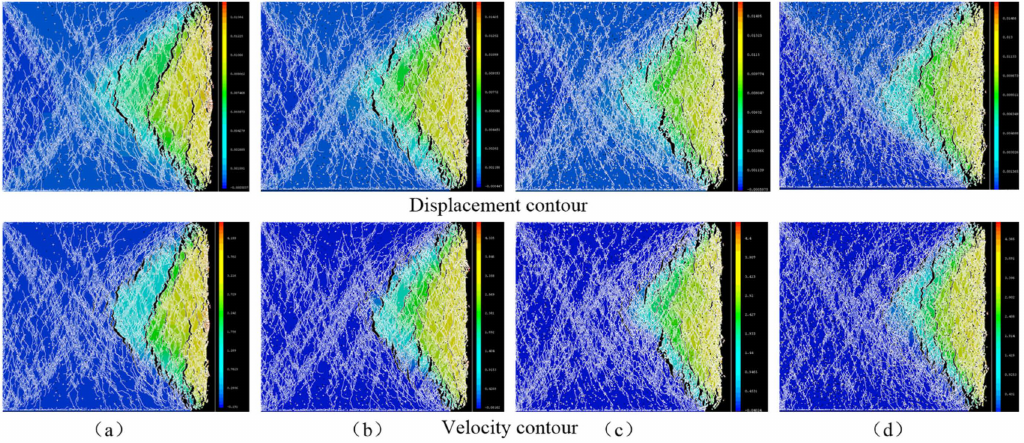
Figure 6. The crack distribution, displacement and velocity contour of numerical samples: ( a ) 0.01 of pore ratio; ( b ) 0.025 of pore ratio; ( c ) 0.05 of pore ratio; and ( d ) 0.075 of pore ratio.